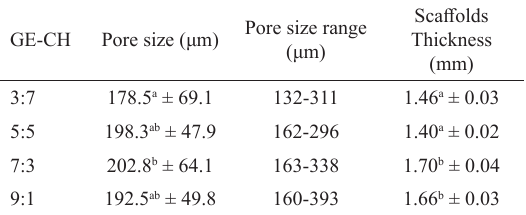
Table 2: Effect of GE:CH ratio on the porous size and porous size range of the scaffolds. GE-CH Pore size (μm)